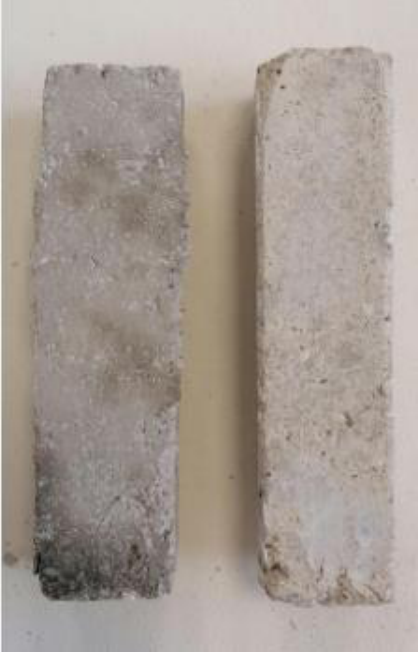
Figure 9. Cement specimens without retrofitting reinforcement.